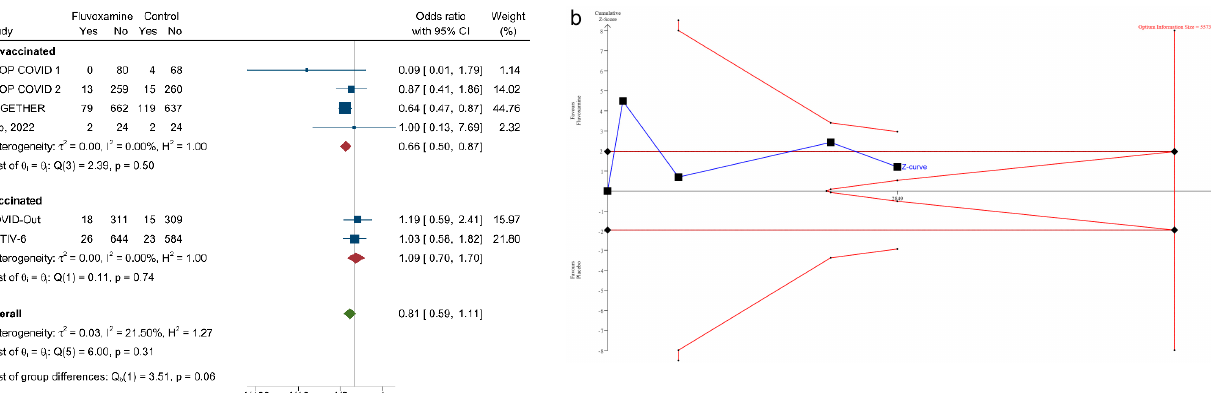
Figure 6. ( a ). Forest plot of random effects meta-analysis, excluding the STOP COVID 2 study in clinical deterioration. ([7,8,16–18]) ( b ). Trial sequential analysis of the sensitivity test excluding STOP COVID 2 ([6]) on the primary outcome using a 30% relative risk reduction threshold.